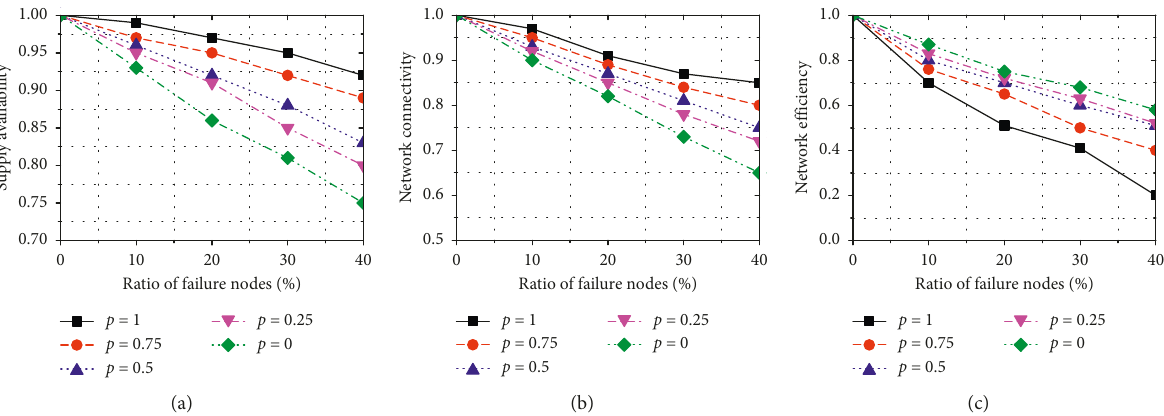
Figure 8: Military Logistic Network under targeted disruption. (a) Supply availability. (b) Network connectivity. (c) Network efficiency.